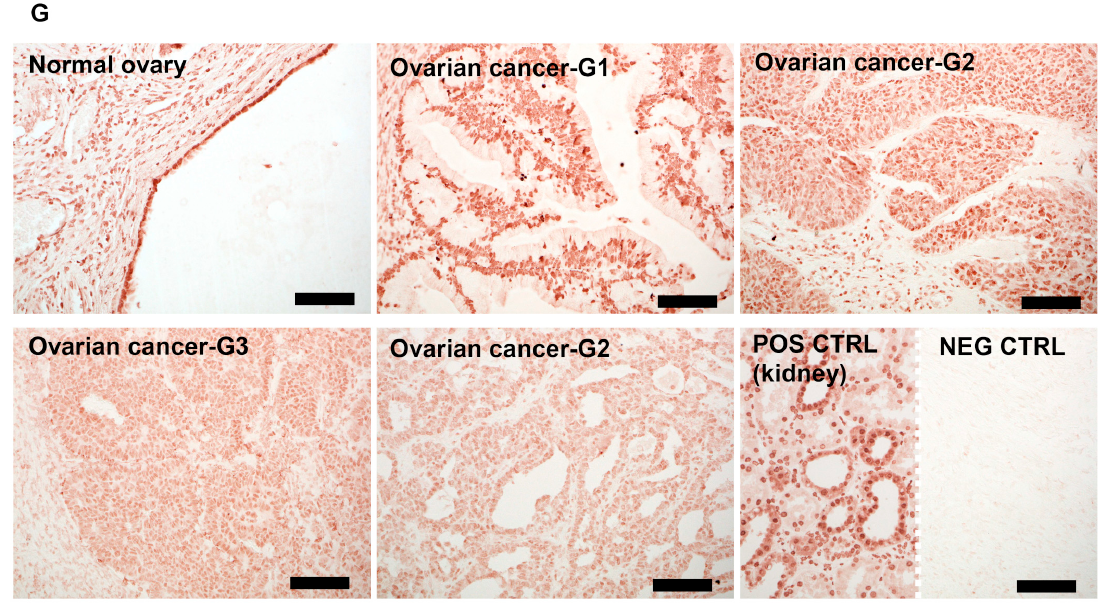
Figure 4. Cytoplasmic and nuclear vitamin D receptor (VDR) immunostaining in normal ovary and ovarian tumors ( n = 20) ( A , B ), in relation to tumors grade in primary tumors ( n = 57) ( C , D ) and in metastatic tumors ( n = 13) ( E , F ). Statistically significant differences are denoted with asterisks as determined by ANOVA (black asterisks) or Student’s t -test (red asterisks, * p < 0.05, ** p < 0.01, *** p < 0.001). ( G ) Representative VDR immunostaining in normal epithelia, ovarian cancers, and positive (POS CTRL) and negative (NEG CTRL) controls. Scale bars = 50 μ m.